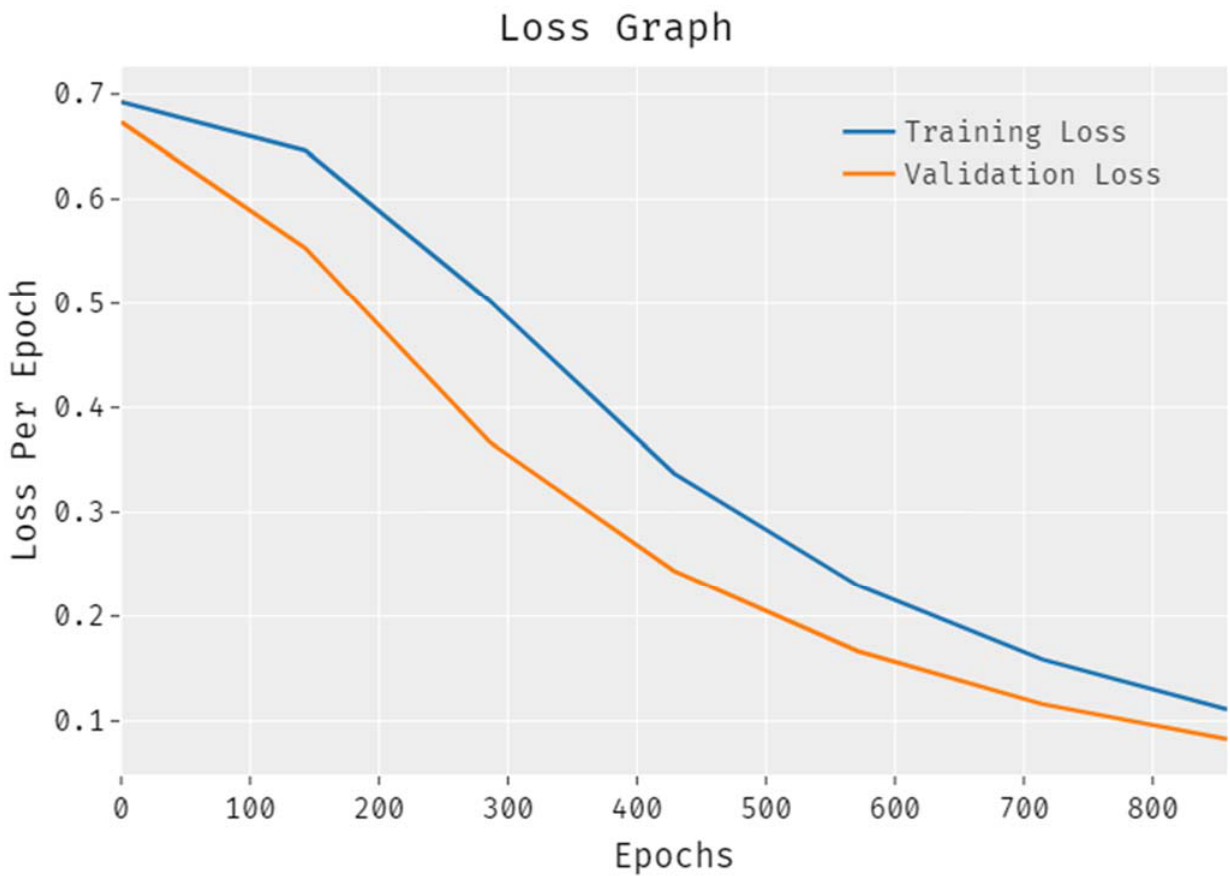
Figure 7. Loss graph analysis for the EDLCDS ‐ BCDC technique.